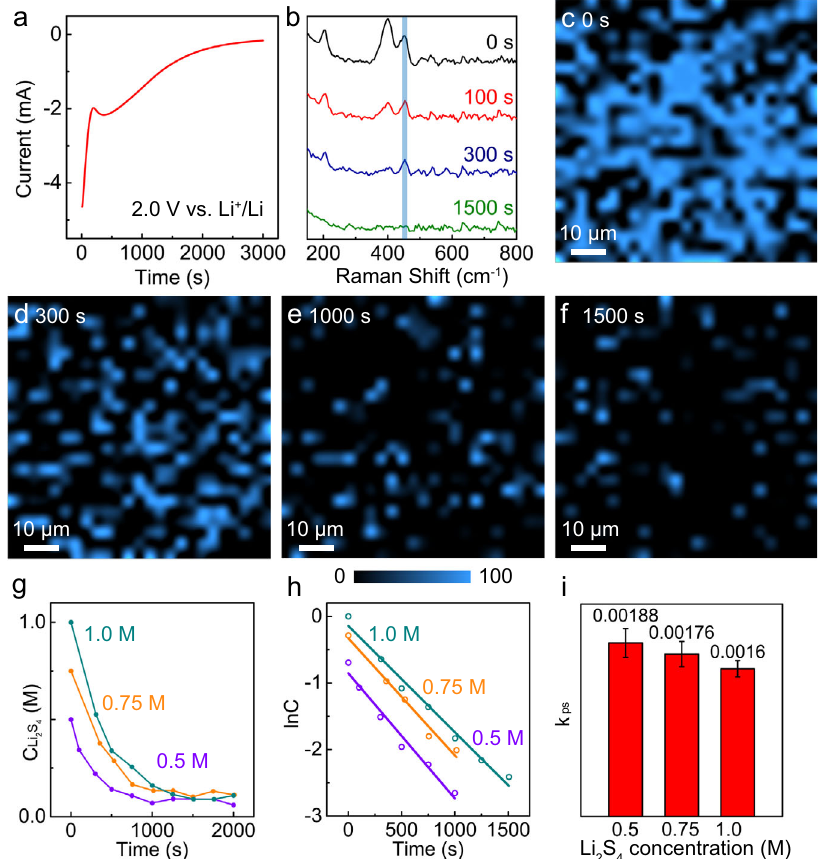
Fig. 2 | Reduction of polysul fi des at 2.0V vs. Li + /Li. a Chronoamperometric current-time transient of polysul fi de reduction at 2.0V (vs. Li + /Li). Operando Raman ( b ) spectra and c – f mapping images of the cathode during reduction in 1.0MLi 2 S 4 electrolyte.Thebluecolorin c – f representstheregionat400cm − 1